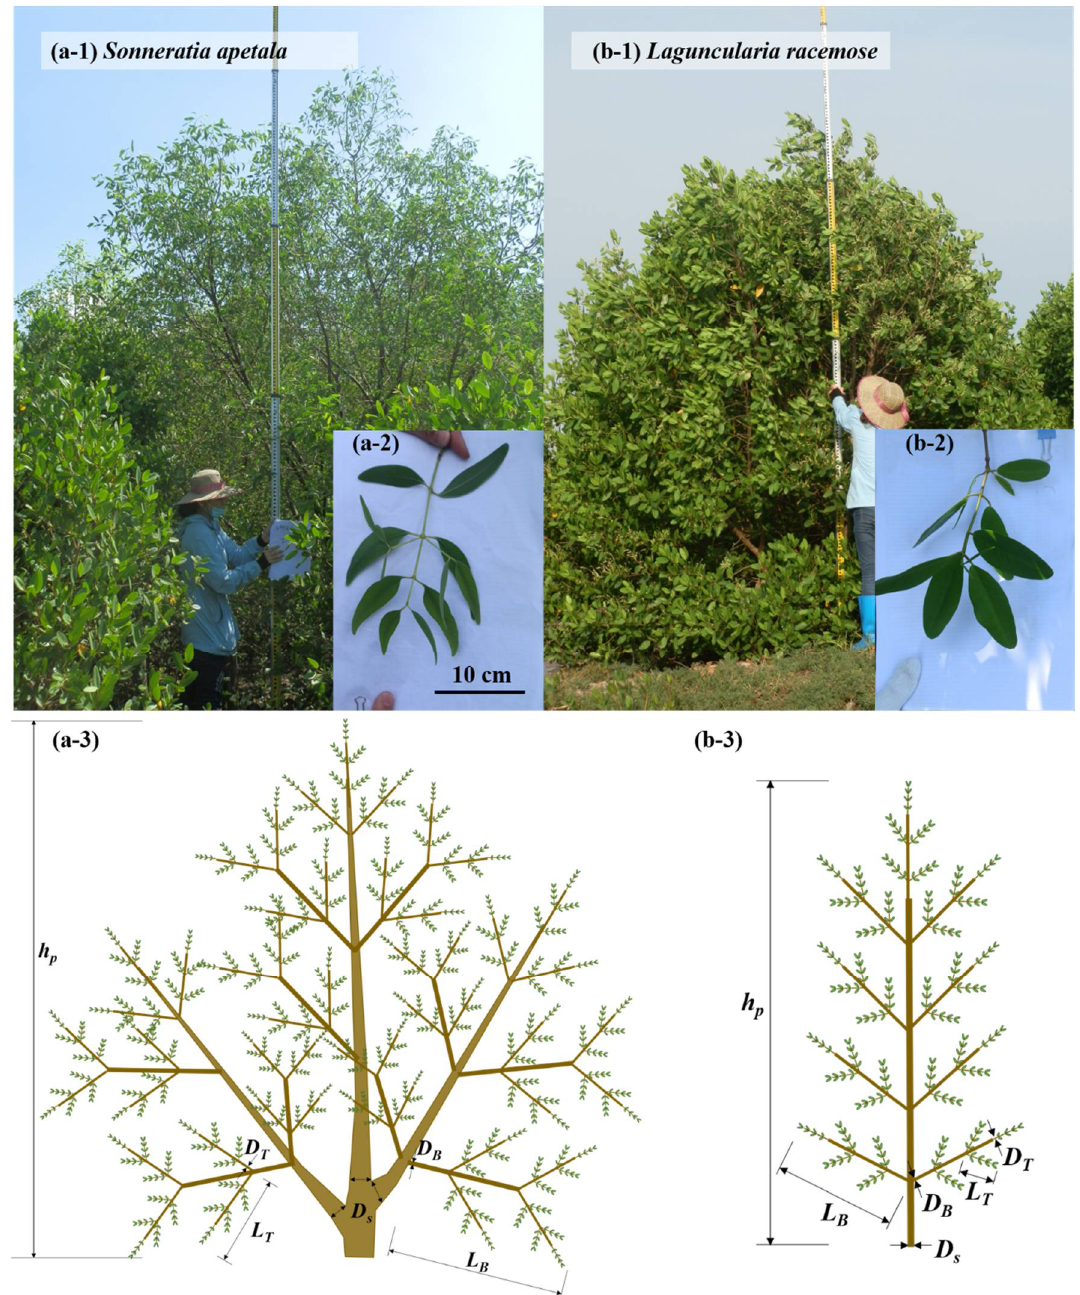
Figure 2. Photo of one individual tree ( a-1 ), photo of the leaves ( a-2 ), and illustration of one tree ( a-3 ) for Sonneratia apetala . Photo of one individual tree ( b-1 ), photo of the leaves ( b-2 ), and illustration of one stem ( b-3 ) for Laguncularia racemosa . The plant height is h p , the length and diameter are denoted with L and D , with the subscript s , B , and T indicating parameters for the stem, branch, and twig, respectively.